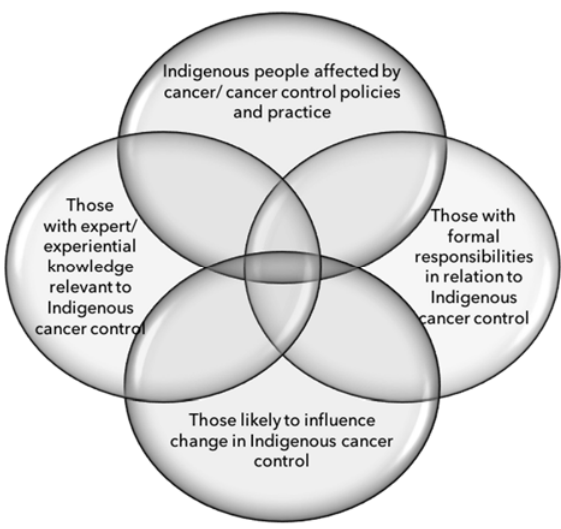
Figure 1. Categories of stakeholders identified to be necessary for robust policy development (adapted from [32]). Table 1. Stakeholder contributions and functions in consultation process.